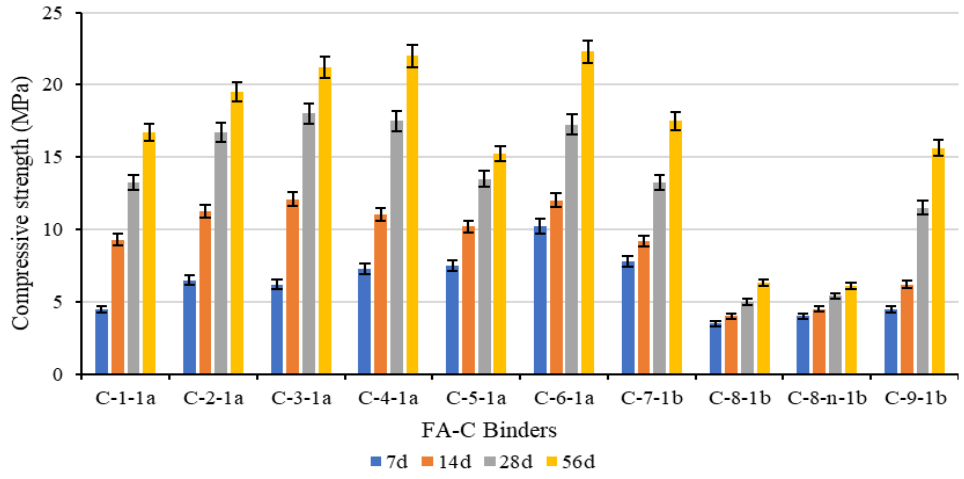
Figure 3. Influence of reagents (1a and 1b) on FA-C binders.